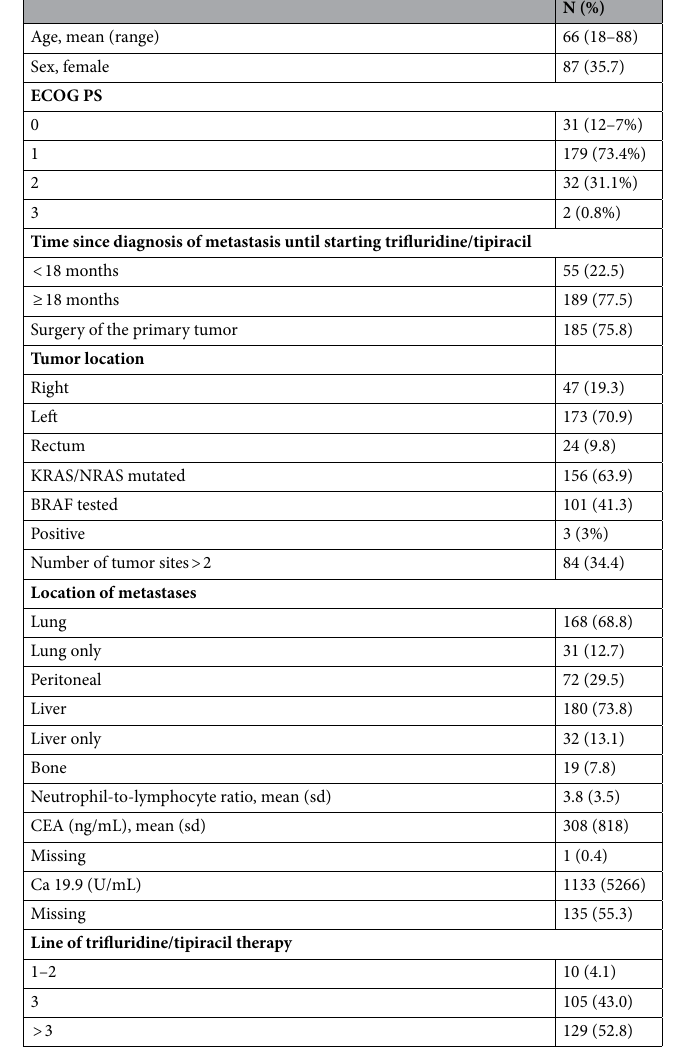
Table 1. Baseline characteristics. ECOG-PS, Eastern Cooperative Oncology Group Performance Status; sd, standard deviation; NLR, Neutrophil–lymphocyte